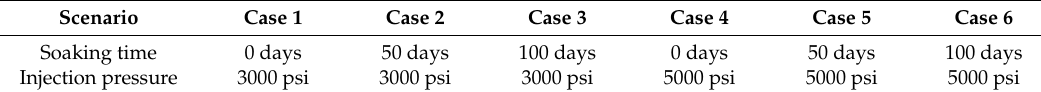
( b ) Figure 16. Pressure distribution. ( a ) Injection time: 50 days; ( b ) Injection time: 100 days. 3.2.3. Effect of Soaking Period